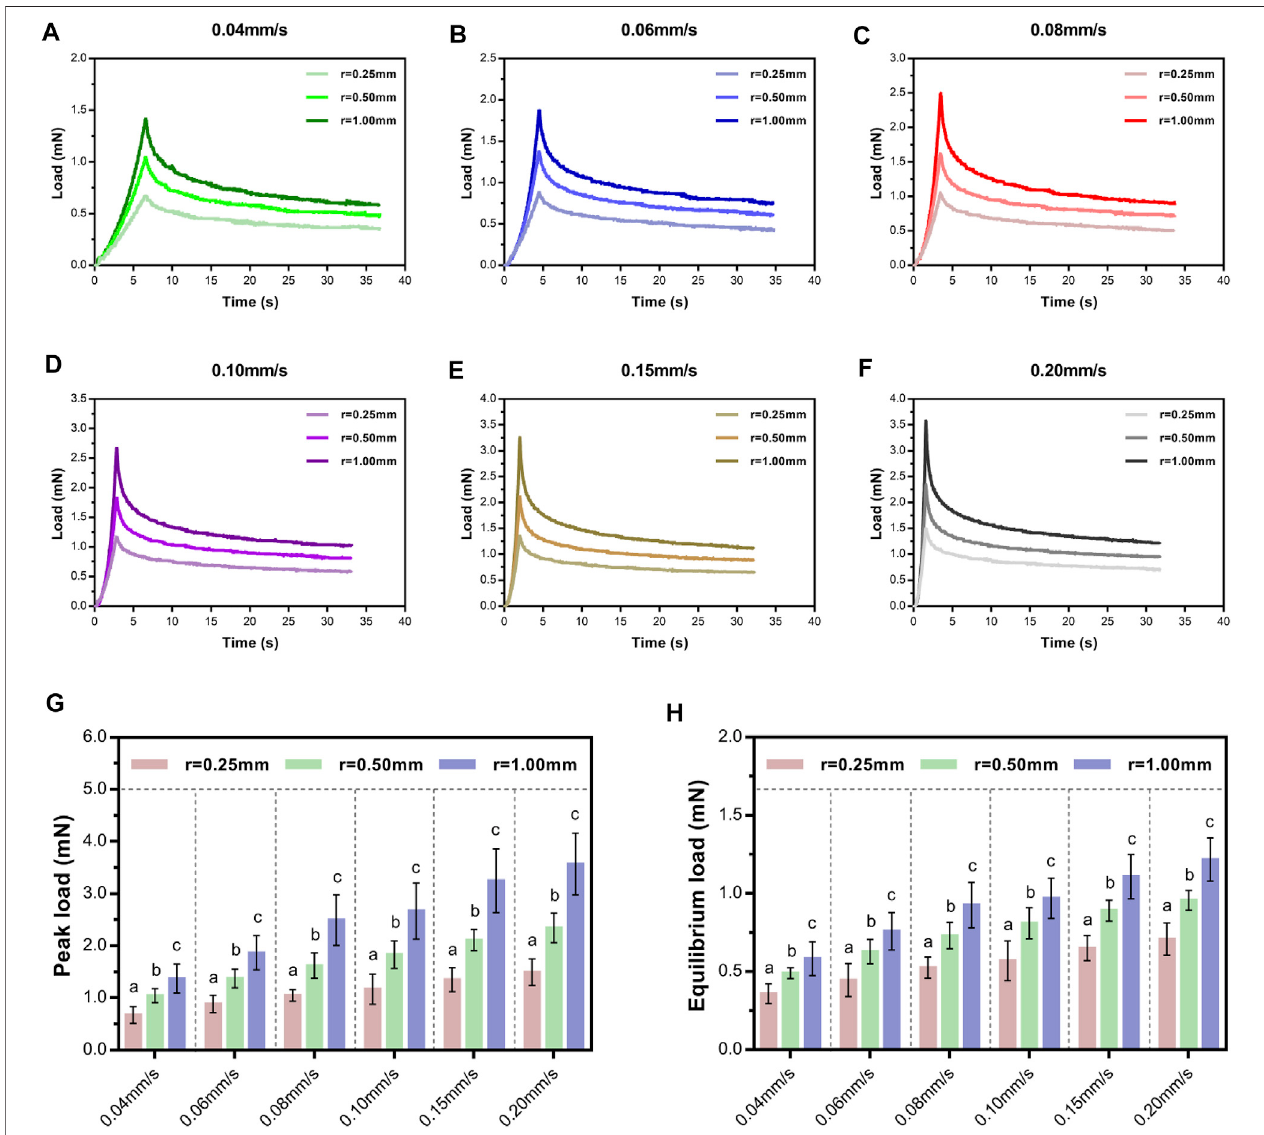
FIGURE 5 | Load – time curves showed loading and relaxation using three indenters of different sizes at varying velocities and held for 30 s (A – F) . Comparison of average peak loads (G) and equilibrium loads (H) of different indenters following a range of rates. Letters indicate signi fi cant differences across velocities within a condition with signi fi cant indenter-size effects. Error bars are standard